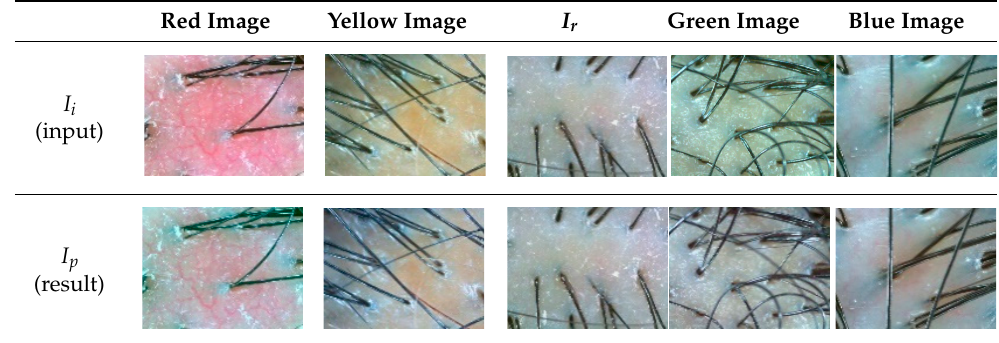
Table 4. Examples of skin color normalization.